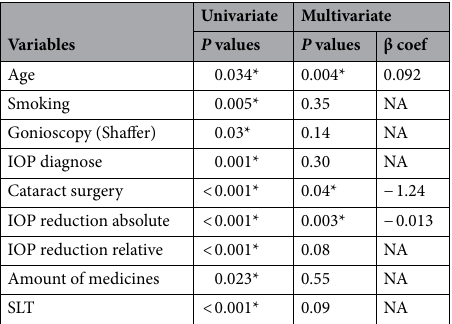
Table 1. Significant variables tested in the univariate and the multivariate linear regression analysis using the MD difference as endpoint. (*) Significant values. MD Mean deviation; IOP Intraocular pressure; SLT Selective Laser Treatment; NA Non-applicable.